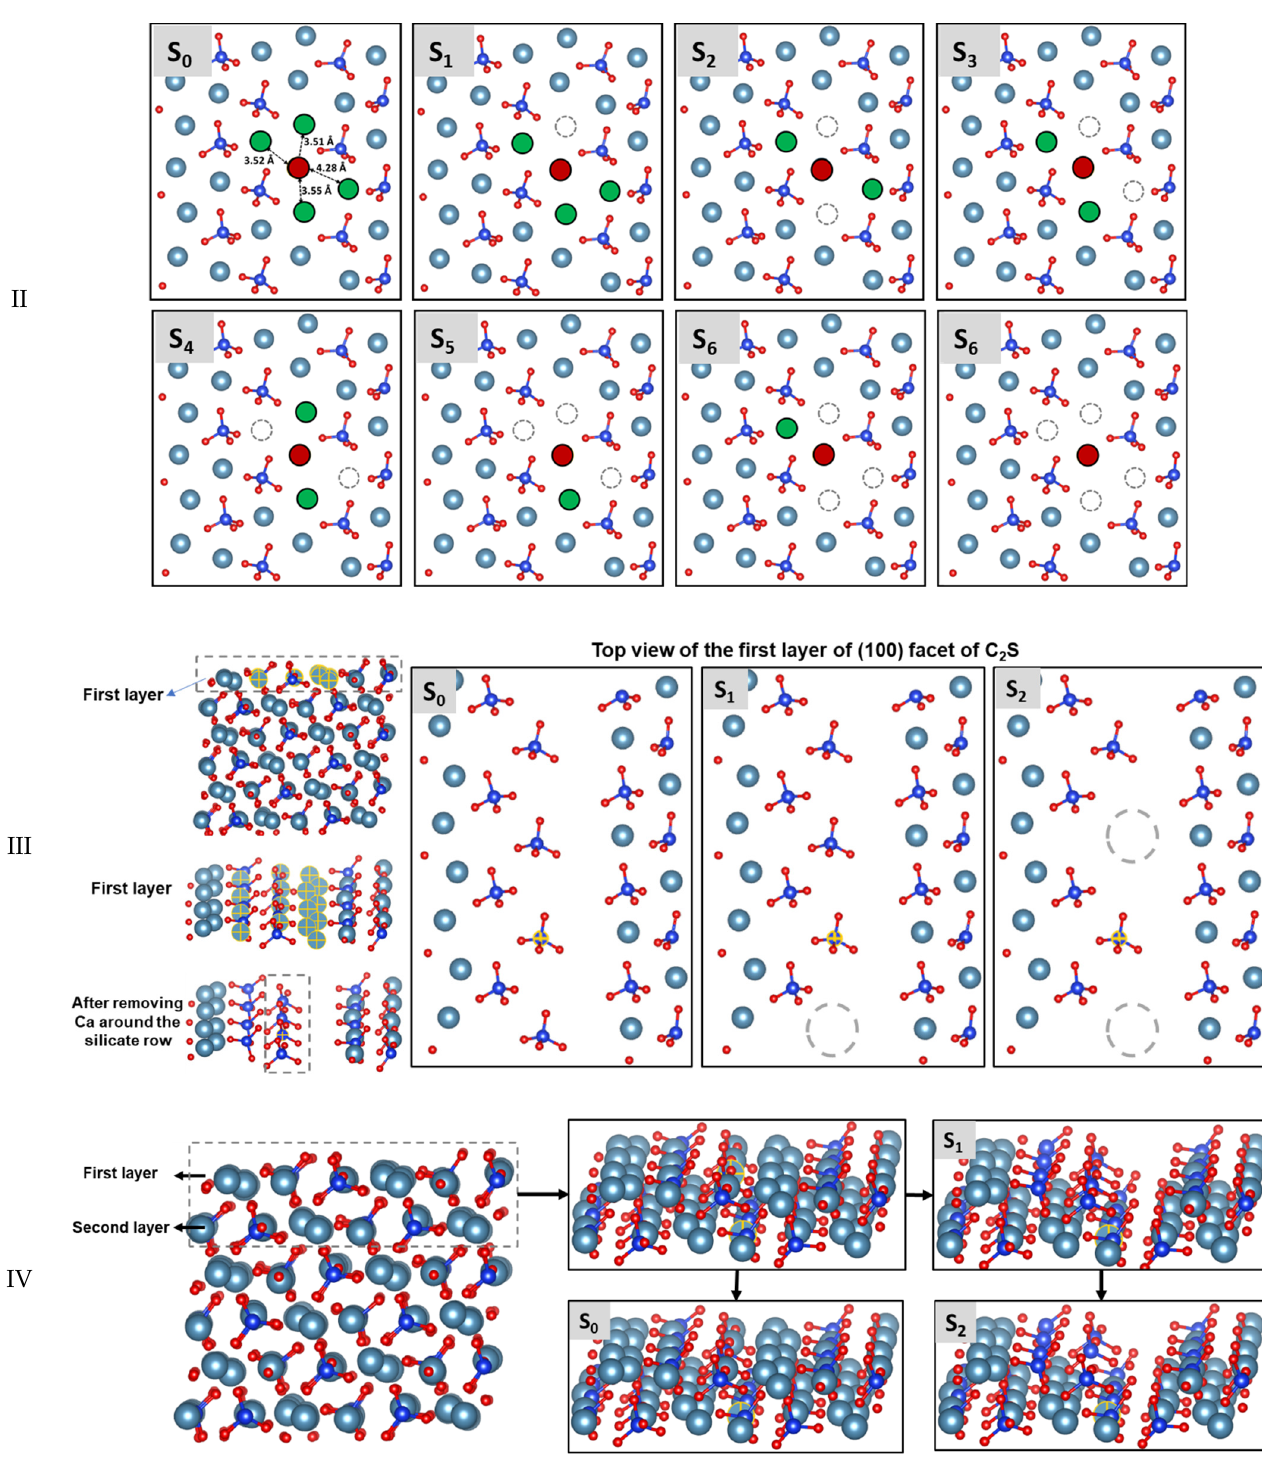
Figure 1. Dissolution scenarios of ( I ) the central Ca (marked red) located in between two silicates (Ca-SiO 4 row); ( II ) the central Ca (red) located in the Ca layer from (100) facet of C 2 S in absence of 1, 2, 3 and 4 Ca neighbors (green) removed at different combinations (scenarios) for both cases (S 0 –S 6 ). ( III ) Dissolution scenarios of central silicate (marked with yellow cross), after stepwise removal of the surrounding Ca and in the presence (a) and absence (b,c) of the two nearest silicate neighbors located in a row. ( IV ) Dissolution behavior of a central Ca (marked yellow cross) located in between two silicates in the second layer (S 1 ; stepwise removal of Ca nearest neighbors (within 5 Å distance) and (S 2 ) one silicate from the first layer.